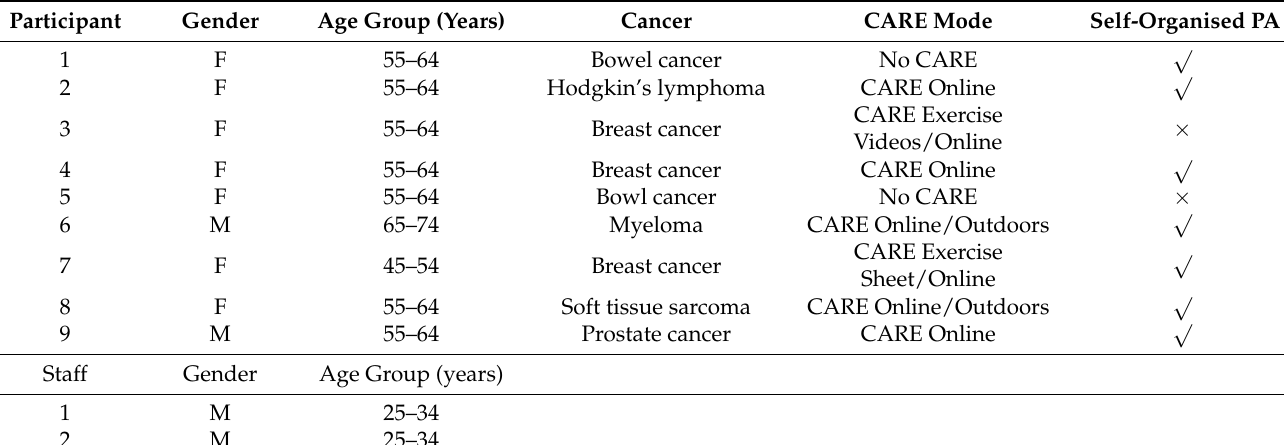
Table 1. The demographic profile of the CARE